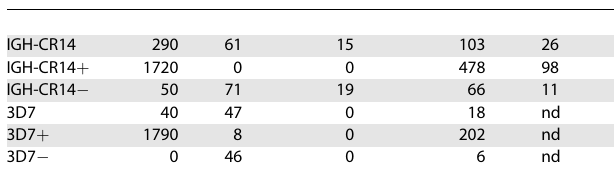
Table 2. Adhesion of P. falciparum Isolates to gC1qR/HABP1, CD36, and ICAM-1, and Endothelial Cell Lines HUVEC and HBMEC P. falciparum a gC1qR/